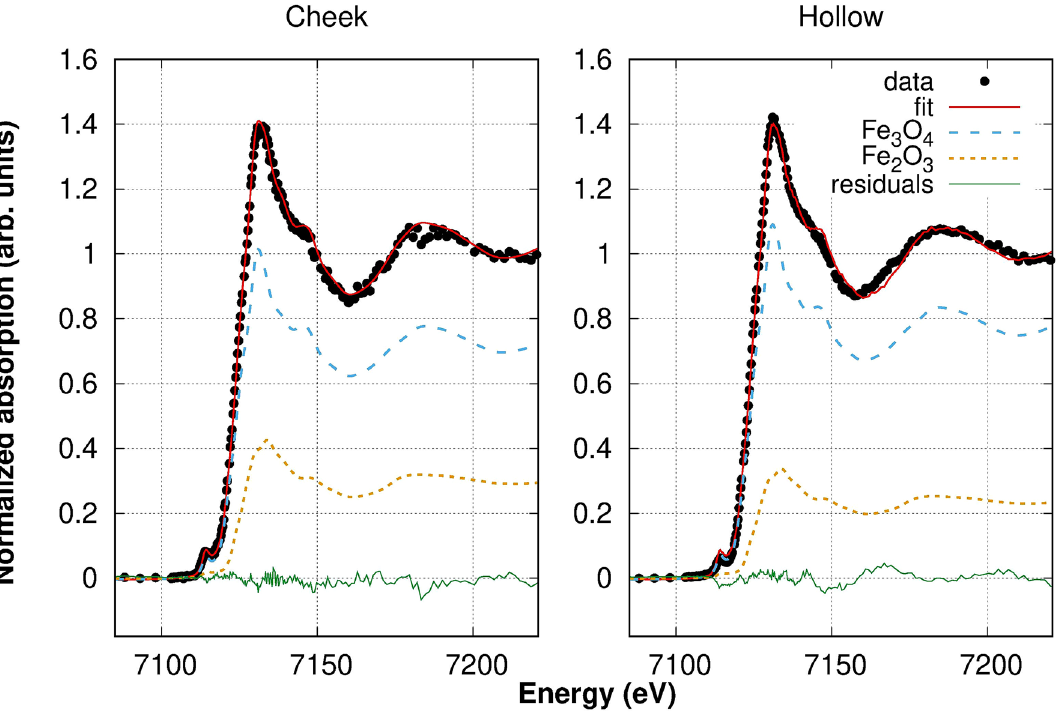
Figure 5. LCF analysis of the Fe K-edge spectra collected on the cheek area (left) and on the hollow area (right) of coin D. In both cases, the contributions needed for the best fit are magnetite (Fe 3 O 4 ) and hematite (Fe 2 O 3